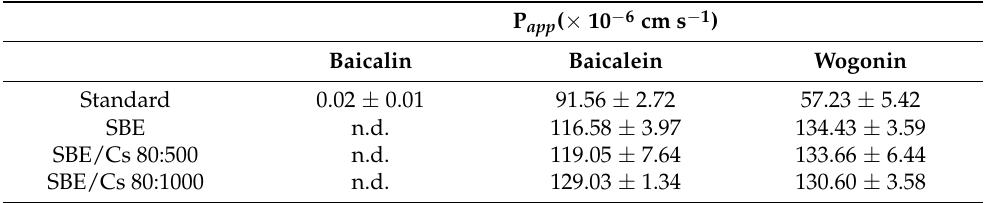
Table 1. Apparent permeability coefficients (P app ) values of standards, S. baicalensis radix extract, and binary